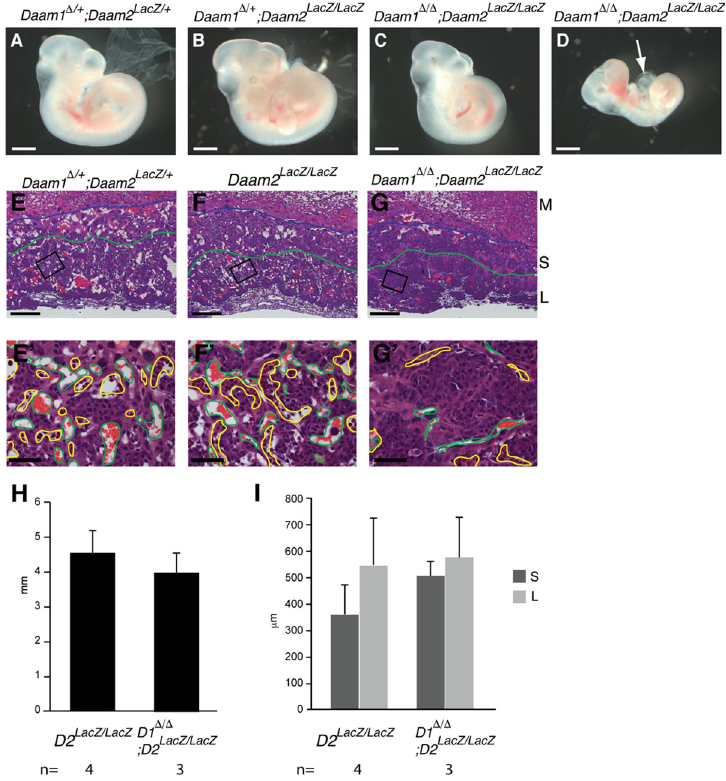
Fig 3. Embryonic developmental delay and placental developmental defects in Daam1/2 -deficient mice. (A-C) Daam1 Δ /+ , Daam2 LacZ/+ (A), Daam1 Δ /+ , Daam2 LacZ/LacZ (B), and Daam1 Δ / Δ , Daam2 LacZ/LacZ (C, D), embryos at E10.5. Some of Daam1 Δ / Δ , Daam2 LacZ/LacZ embryos were found dead with an enlarged pericardial cavity (arrow, D). (E-G, E’- G’) H&E staining of E10.5 placenta sections of Daam1 Δ /+ , Daam2 LacZ/+ (E), Daam2 LacZ/LacZ (F), and Daam1 Δ / Δ , Daam2 LacZ/LacZ (G). High magnification images’ (E’-G’) positions are indicated as boxes on E-G. (H) The size of the placenta of Daam2 LacZ/LacZ and Daam1 Δ / Δ , Daam2 LacZ/LacZ was measured as described for Fig 2E. (I) The thickness of the spongiotrophoblast layer (S) and labyrinthine layer (L) in Daam2 LacZ/LacZ and Daam1 Δ / Δ , Daam2 LacZ/LacZ , measured as described in Fig 2F. Blue lines depict the boundary between the maternal decidua (M) and spongiotrophoblast layer (S), and green lines depict the boundary between the spongiotrophoblast and labyrinthine layers (L). Maternal blood sinuses and fetal blood vessels are outlined in green and yellow, respectively (E’-G’). Scale bars = 1 mm in A-D, 200 μ m in E-G, 50 μ m in E’- G’.